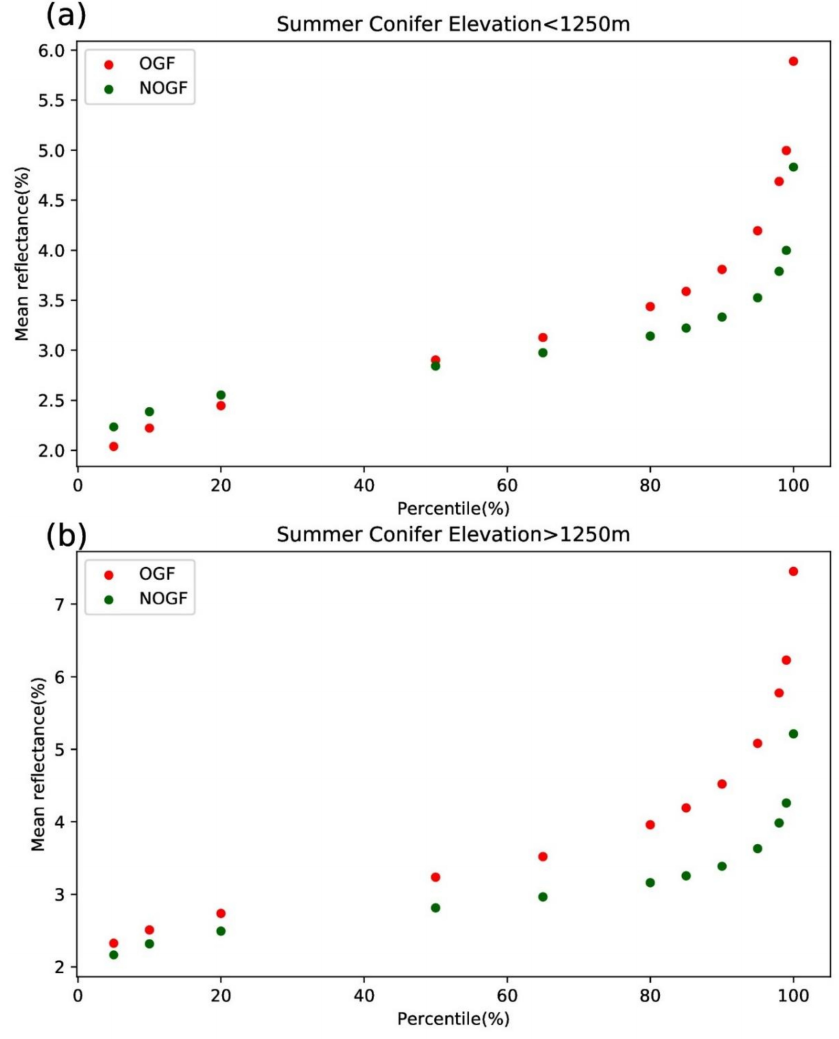
Figure 5. Mean percentile values for the green Band (B3) for conifer Old-Growth Forest and non-Old- Growth Forest polygons with mean elevation ( a ) below 1250 m ( b ) above 1250